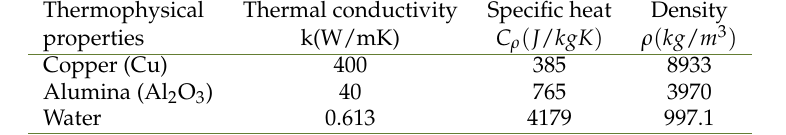
Table 1. The thermophysical properties of nanoparticles and base fluid referred in [4] Thermophysical Thermal